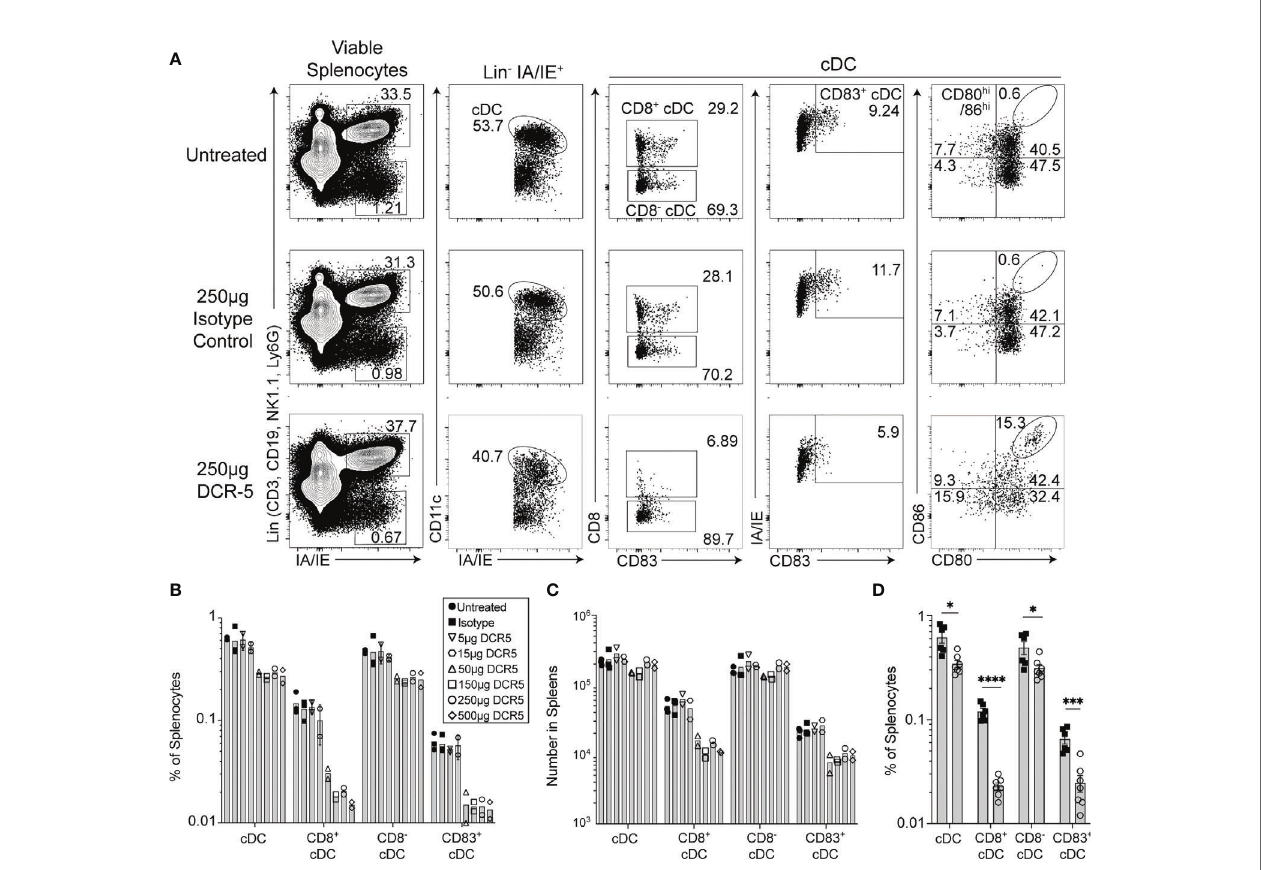
FIGURE 4 | In vivo treatment of mice with DCR-5 results in depletion of DC. B6 mice treated with a single i.p. injection of increasing doses of DCR-5 mAb or 250 µg rat IgG2a isotype control were analyzed 48 h later for DC depletion and Treg induction by fl ow cytometry. (A) Flow cytometry plots showing splenic DC populations in untreated, 250 µg DCR-5 and 250 µg isotype control treated mice. The Lin + /IAIE + gate shown contains >98% CD45R + B cells ( Supplementary Figure 1A ). Graphs showing (B) frequency and (C) total numbers of DC populations in spleens of mice of all treatment groups. P < 0.001 variance for treatment, 2-way ANOVA. (D) Combined data from four experiments showing frequency of DC populations in B6 mice treated with 250 µg DCR-5 or isotype control. Statistical comparison was determined using T-tests. *p < 0.05, ***p < 0.001 and ****p <